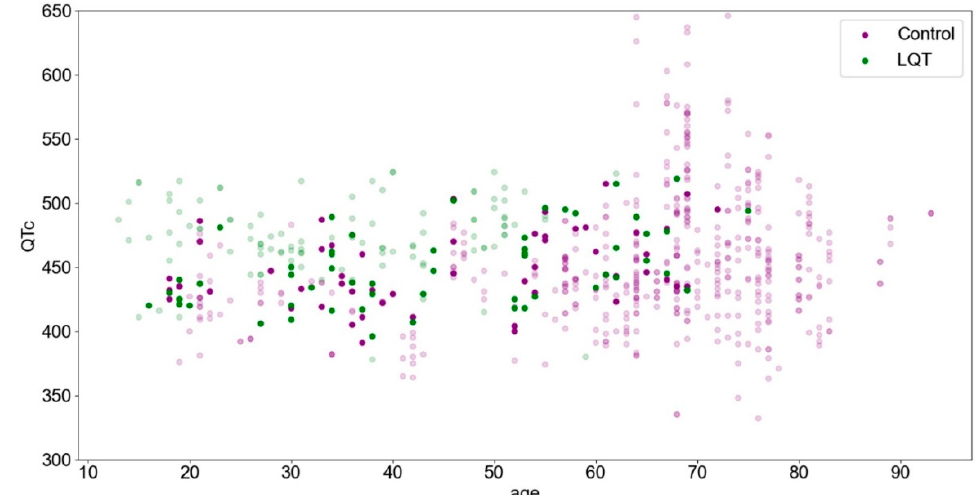
Figure 1. The study cohort is presented according to age and QTc parameters. The highlighted points represent the matched subset. Table 2. Performance metrics of the three considered classifiers in discriminating an ECG measurement from a patient with congenital LQTS from the control cohort depending on the complete or matched test set (mean (±SD) of 25 cross-validation splits). Cohorts were matched according to QTc and Age. AUC, area under the curve; SVC, support vector machine; FCN, fully convolutional network.